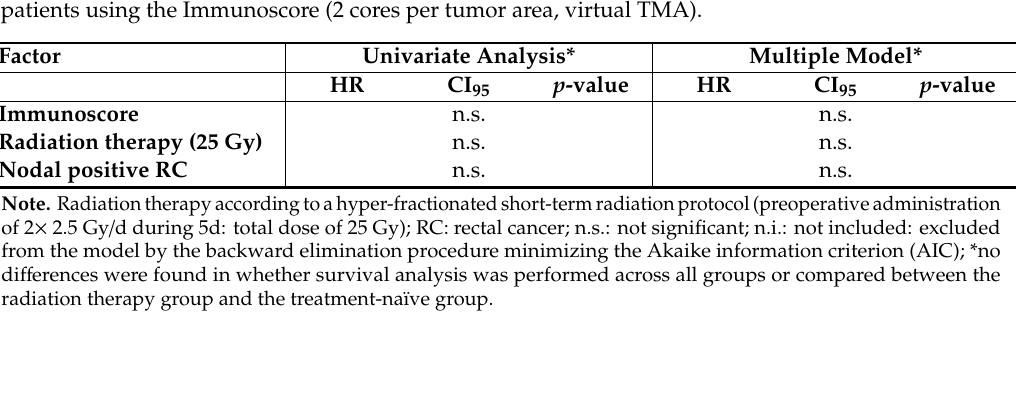
Multiple Models